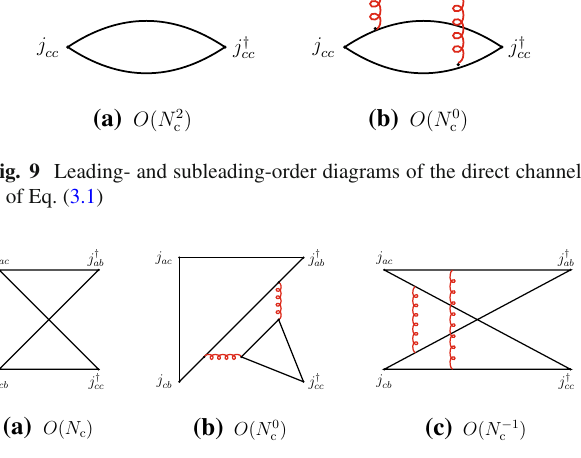
Fig. 10 Leading- and typical subleading-order diagrams of the recom- bination channel of Eq. (3.1)